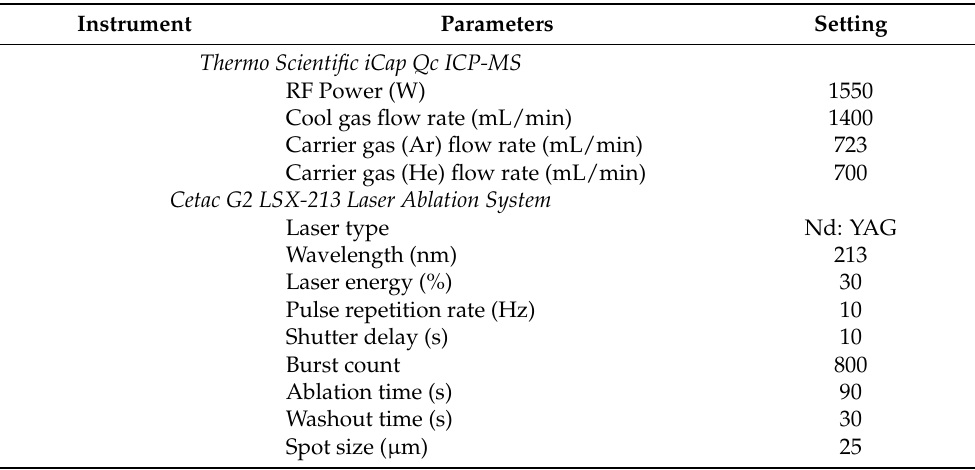
Table A3. Big Ridge Kb-A (laser runs A1–A3), Big Ridge Kb-B (laser runs B1-B3), Big Ridge Kb-C,